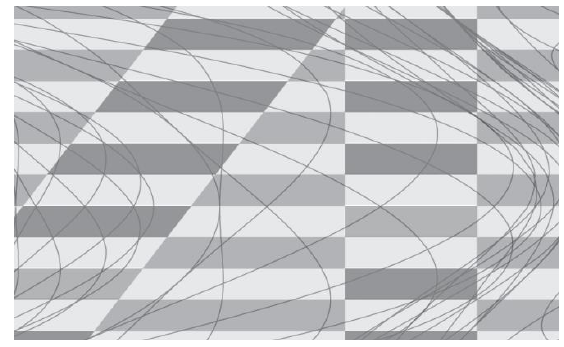
Figure 7. Creating a security element.